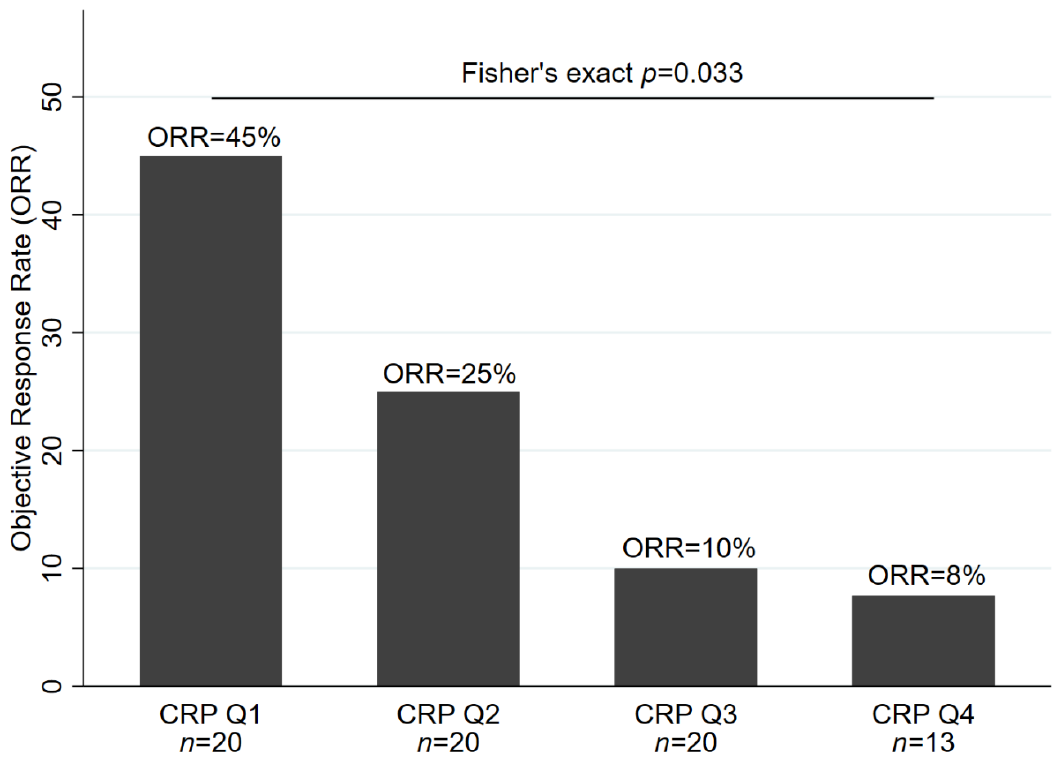
Figure 1. Baseline C-reactive Protein (CRP) and physician-assessed radiographic objective response rate in the Graz cohort ( n = 73).